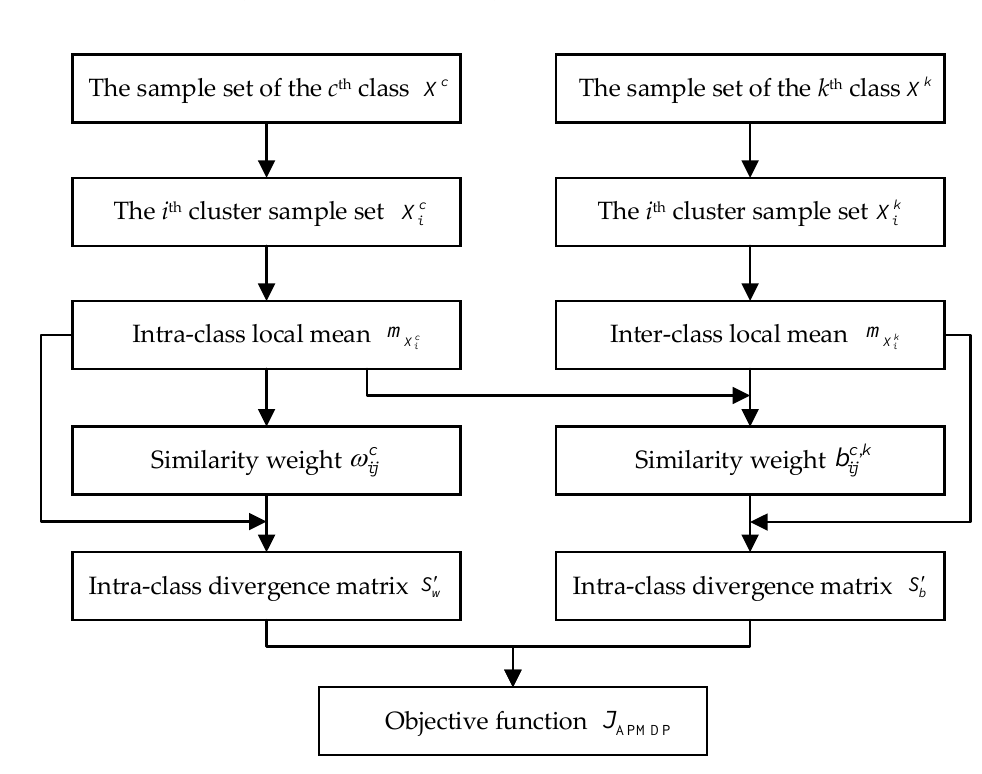
Figure 1. Flow chart of APMDP algorithm.